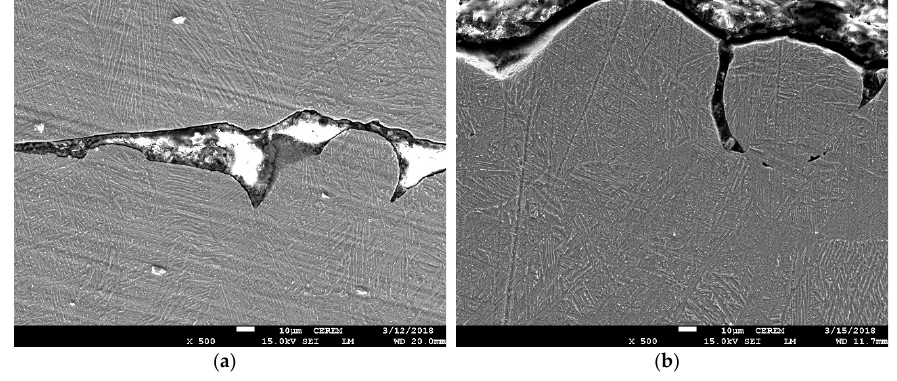
Figure 25. SEM images of 17-mm-diameter and 5-mm-thick cylinders ( a ) with support; and ( b ) without Figure 25. SEMimagesof17-mm-diameterand5-mm-thickcylinders( a )withsupport;and( b supports.